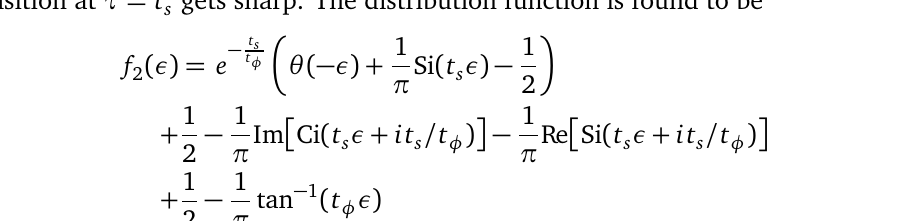
/ t = 1 (black), 10 (red), 100 (green) evolves from an s v